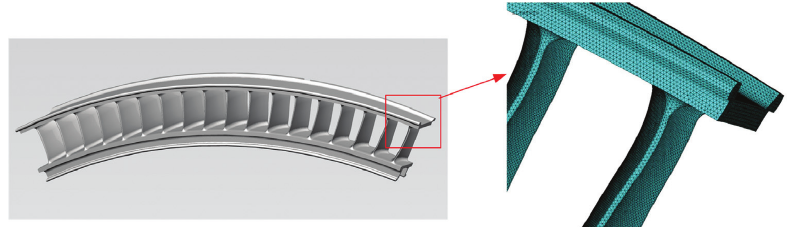
Figure 7: FEM model of the multiblade